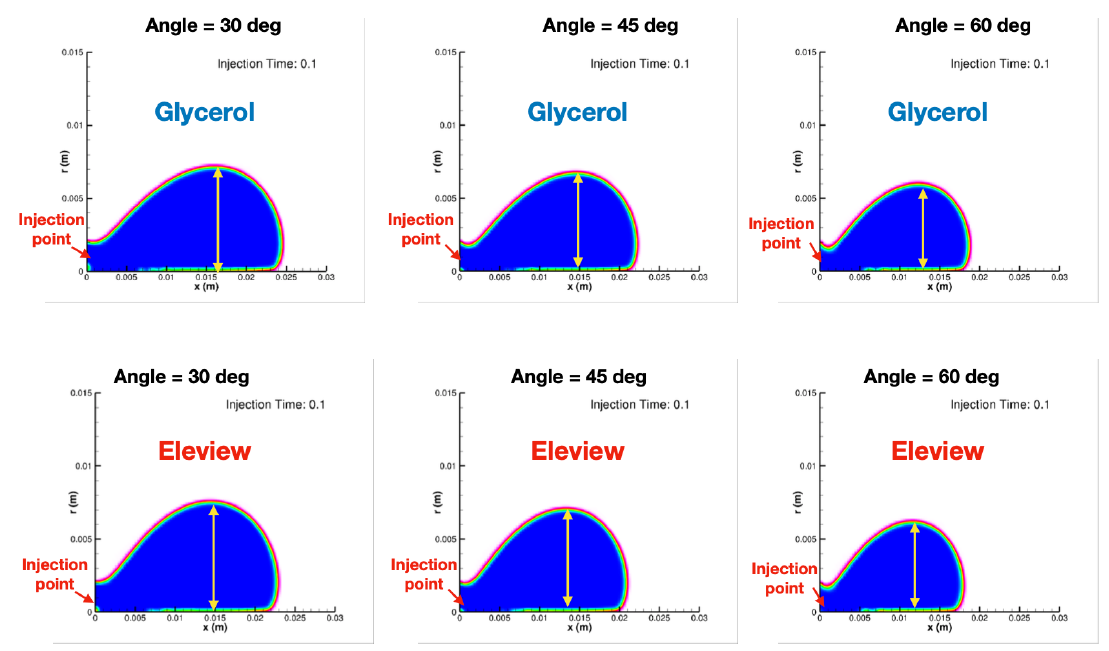
Figure 3. Comparison of two gels in static